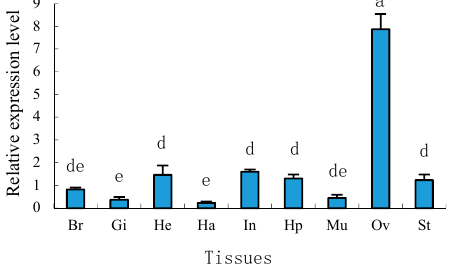
Figure 7. Distribution pattern of Sp-uchl3 in various tissues. Br: brain; Gi: gill; He: heart; Ha: haemolymph; In: intestine; Hp: hepatopancreas; Mu: muscle; Ov: ovary; St: stomach. The lowercase letters above error bars signify difference as follows: the same letters are not significantly different ( p > 0.05), the adjacent letters are significantly different ( p < 0.05), and the intervallic letters are extremely significantly different ( p < 0.01).